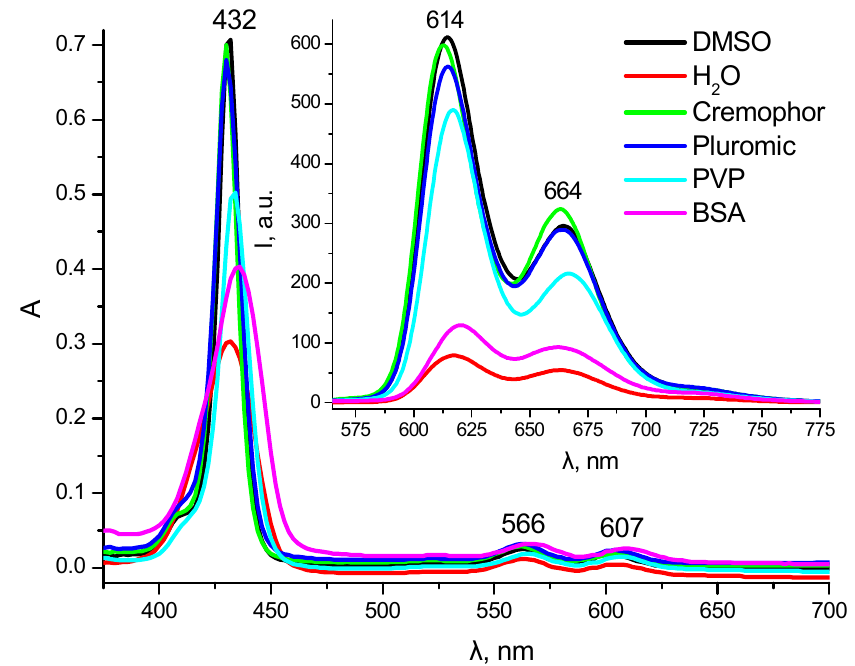
Figure 3. UV–Vis absorption and fluorescence (insert) spectra of 7 (C = 1.8 µ M) in DMSO, water, and aqueous solutions of different solubilizers ( λ ex = 432 nm).